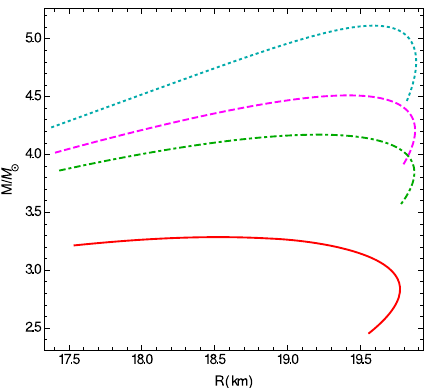
Fig. 5 Variations of ¯ ζ (left panel) and of ¯ V tions of η for stiff-fluid three-form stars in the presence of the Higgs potential, for ¯ a = 0 . 003 and three different values of the Higgs poten- tial parameter ¯ b : ¯ b = 0 (dashed curve), ¯ b = − 0 . 033 (dotted curve),